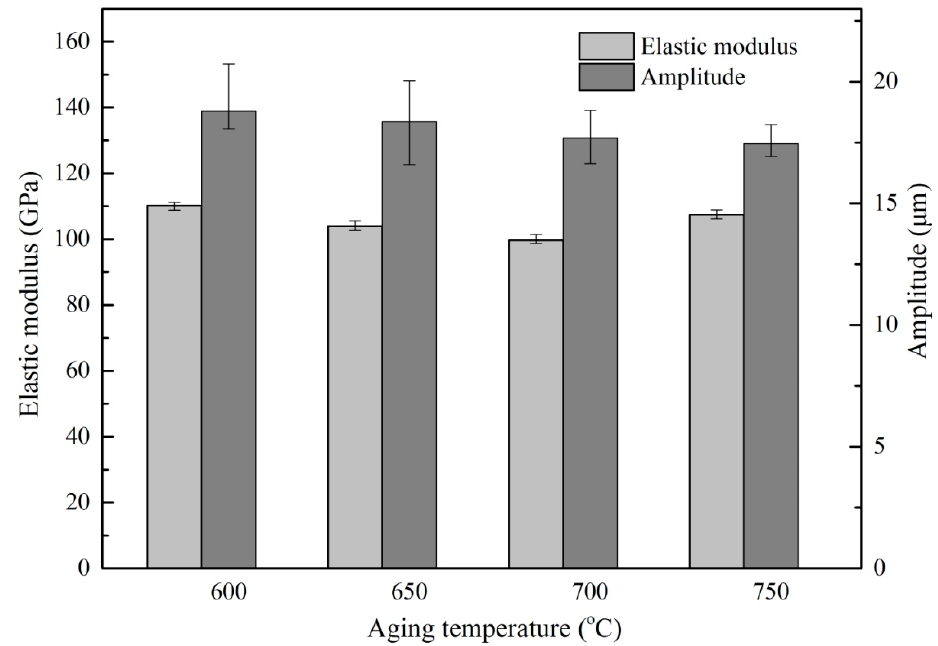
Figure 8. Images of the vibrating and microstructure of Ti6Al4V alloy vibrator under different heat treatment: ( a ) 960 °C × 1 h, AC; ( b ) 980 °C × 1 h, AC; ( c ) 960 °C ×1 h, AC + 600 °C × 2 h, AC; and ( d ) 960 °C × 1 h, AC + 750 °C × 2 h, AC.